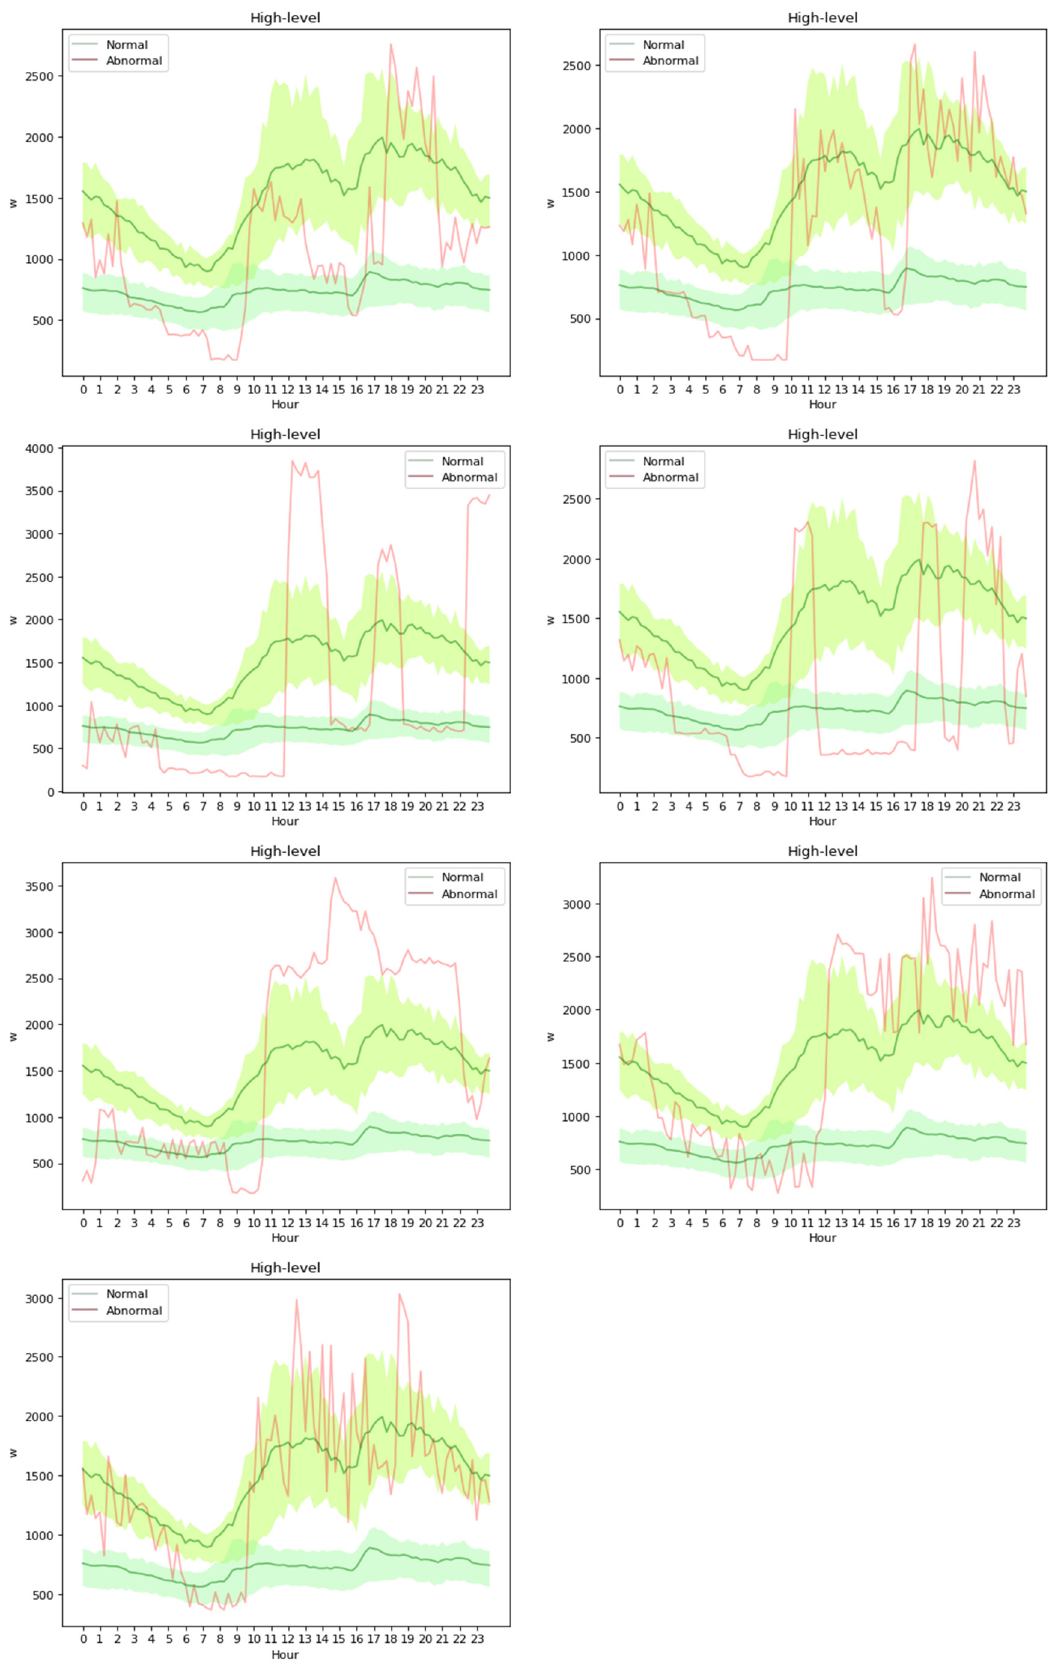
Figure A2. Load profiles of each abnormal electricity consumption events of User 01 using the high-level features.